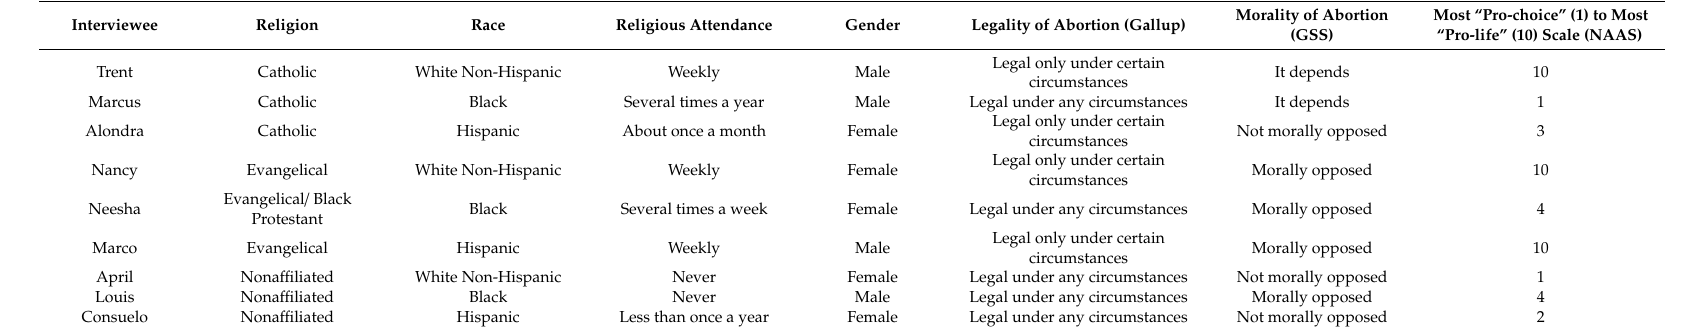
Table 2. Interviewee Subsample